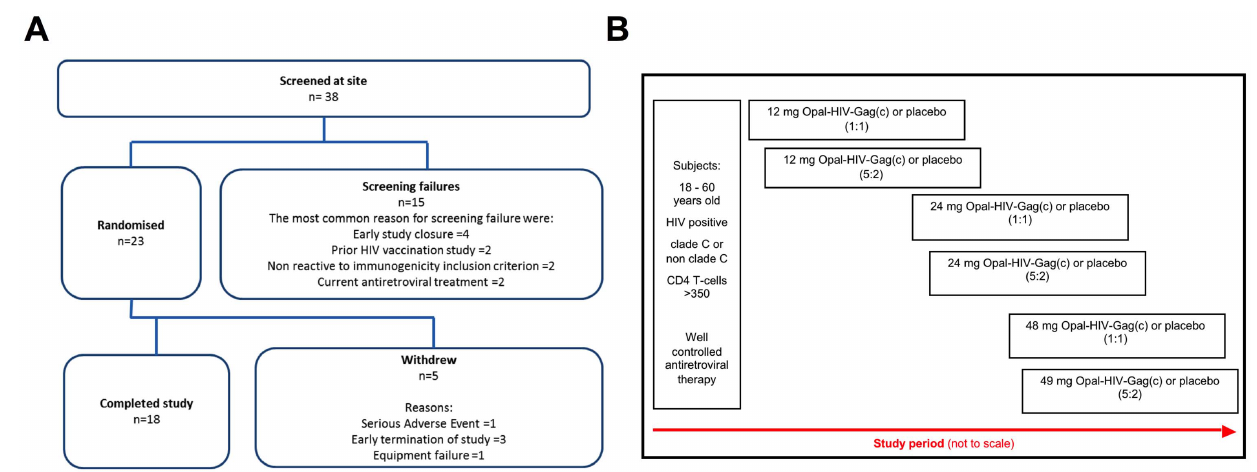
Figure 1. Study subject disposition and allocation to dosing cohorts. (A): Thirty eight subjects were screened for the study, with 23 randomised and 18 completing the study. (B): Diagram showing the planned study allocation to dose escalating cohorts (5:2) and with sentinel cohorts (1:1) shown for the 12 mg, 24 mg and 48 mg dose groups.